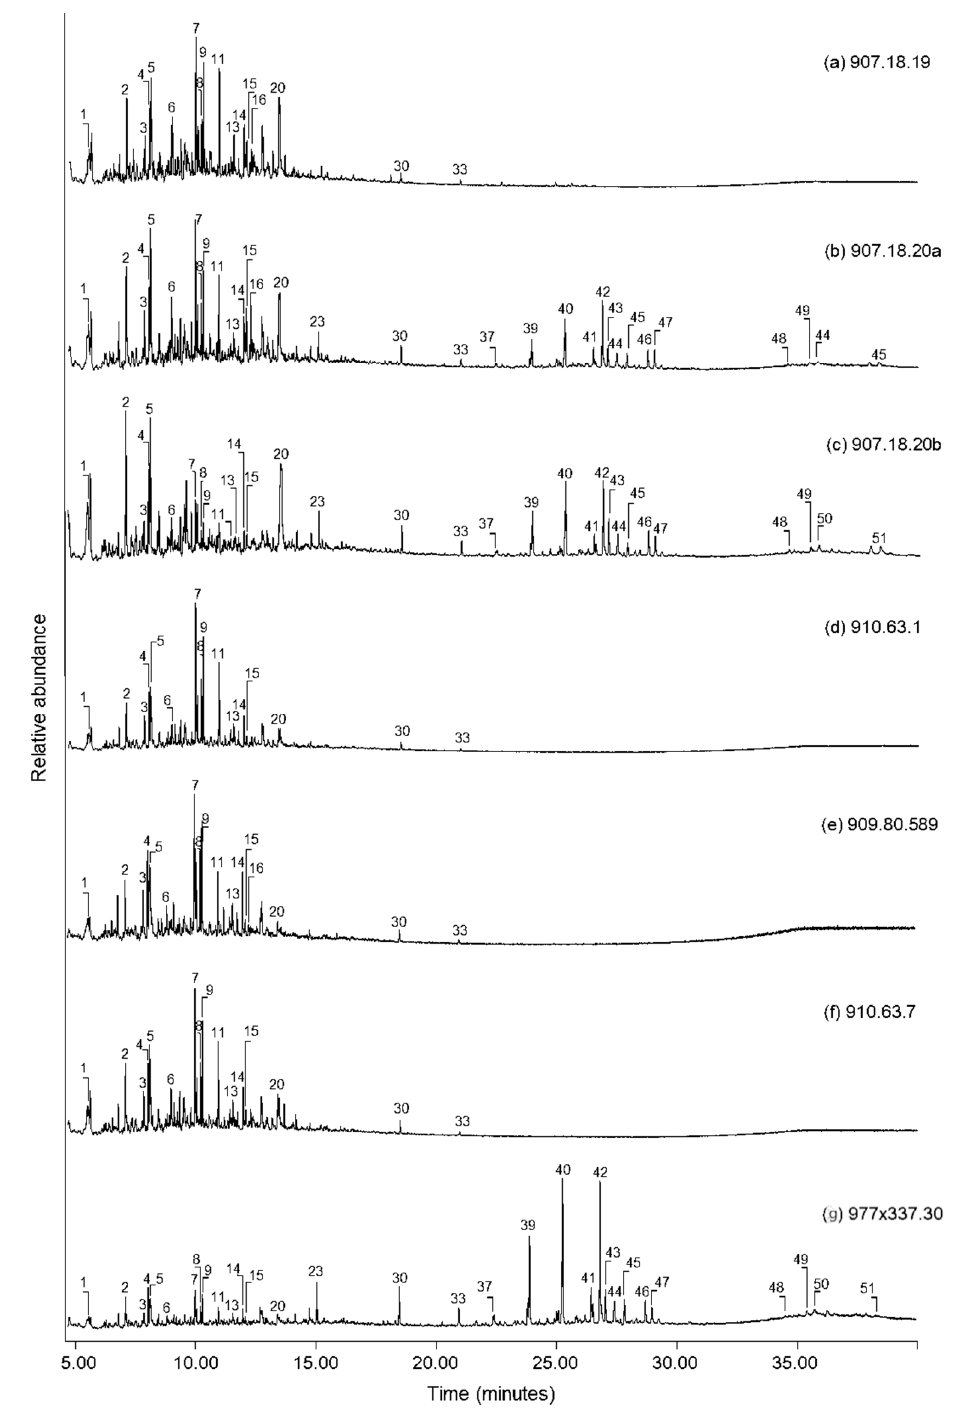
Figure 5. Total ion chromatograms obtained by TMAH Py-GC-MS of threads from pleated linen textiles. Peak labels correspond to compounds listed in Table